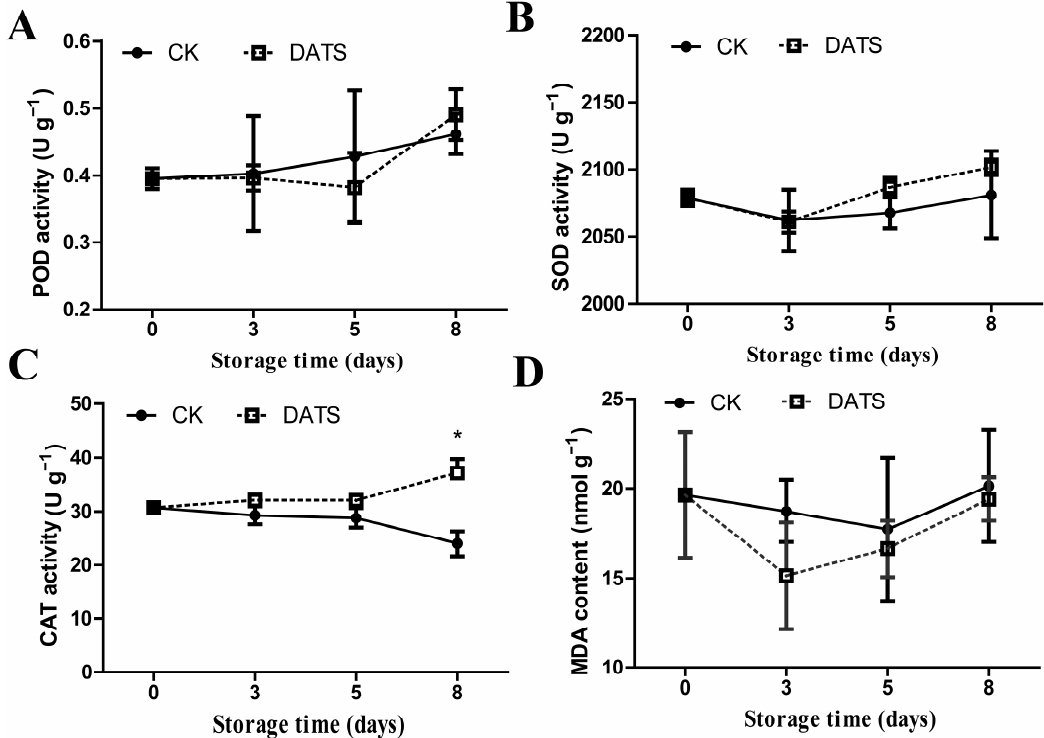
Figure 2. Effect of DATS treatment on enzyme activities of POD ( A ), SOD ( B ), CAT ( C ), and MDA ( D ) of potato tubers. CK: control; DATS: diallyl trisulfide; POD: peroxidase; SOD: superoxide dismutase; CAT: catalase; MDA: malondialdehyde. * p < 0.05; data are shown as means ± SD.